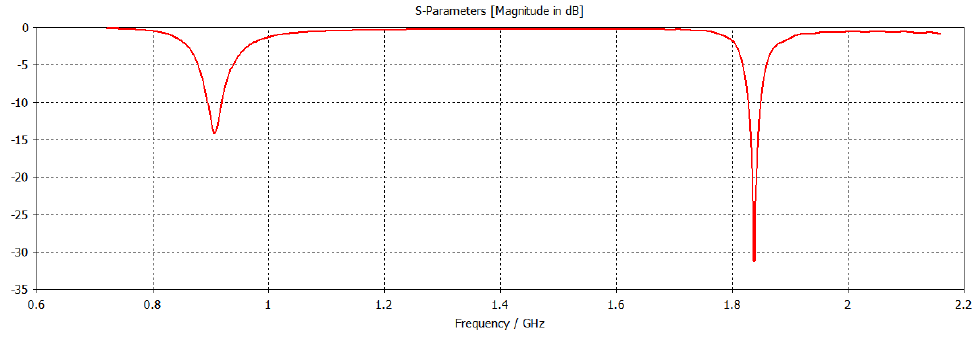
Figure 11. Return Loss (U-slot antenna)